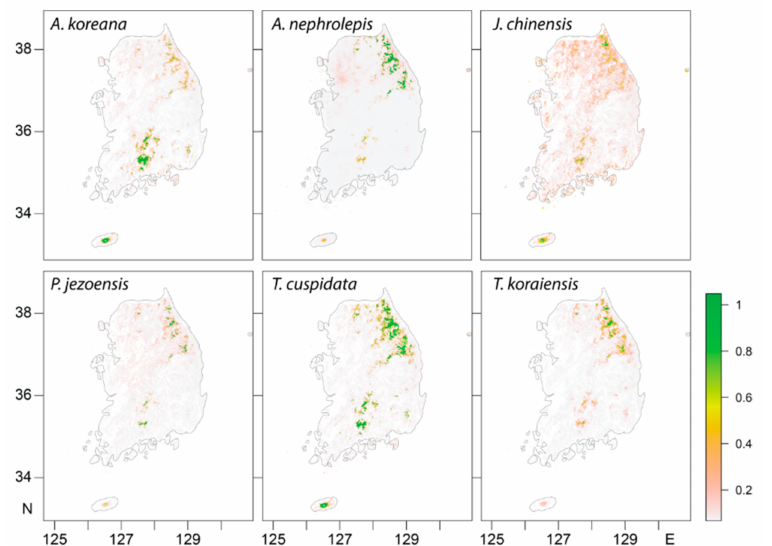
Figure 3. Land suitability maps of six subalpine forest species in Korea under the current (1970–2000) climate